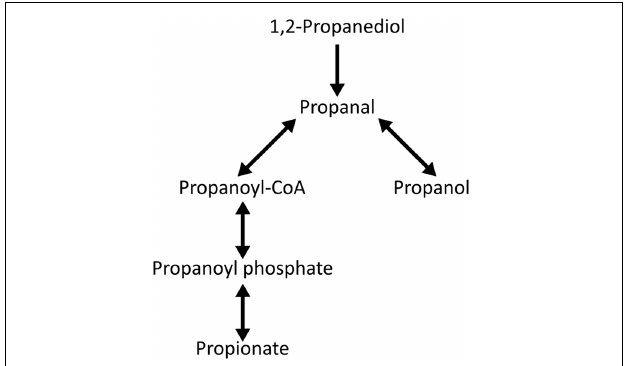
FIGURE 6 | The 1,2-Propanediol degradation pathway in L. monocytogenes strain 10403s based on BioCyc Database Collection (BioCyc, 2012). Reversible pathway is indicated by double